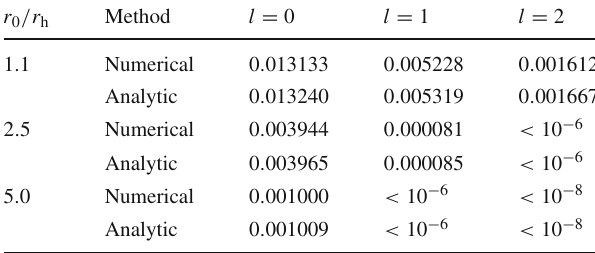
Table 3 Spectraof energy radiatedtothe event horizon inthe ZFL. The numerical results are compared with the exact values given by Eq. (46) for l = 0 , 1 , 2, considering the source released from rest at a certain finite position r 0 r 0 / r h